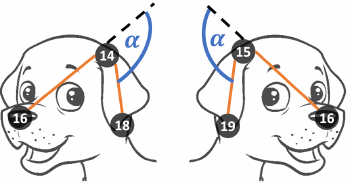
Figure 6. Calculation of the ear position.